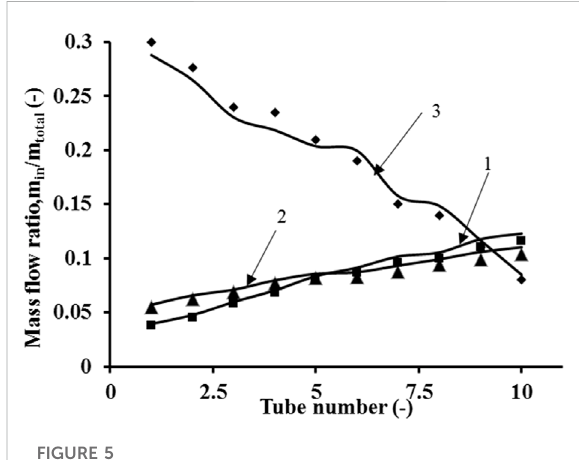
Frontiers in Energy